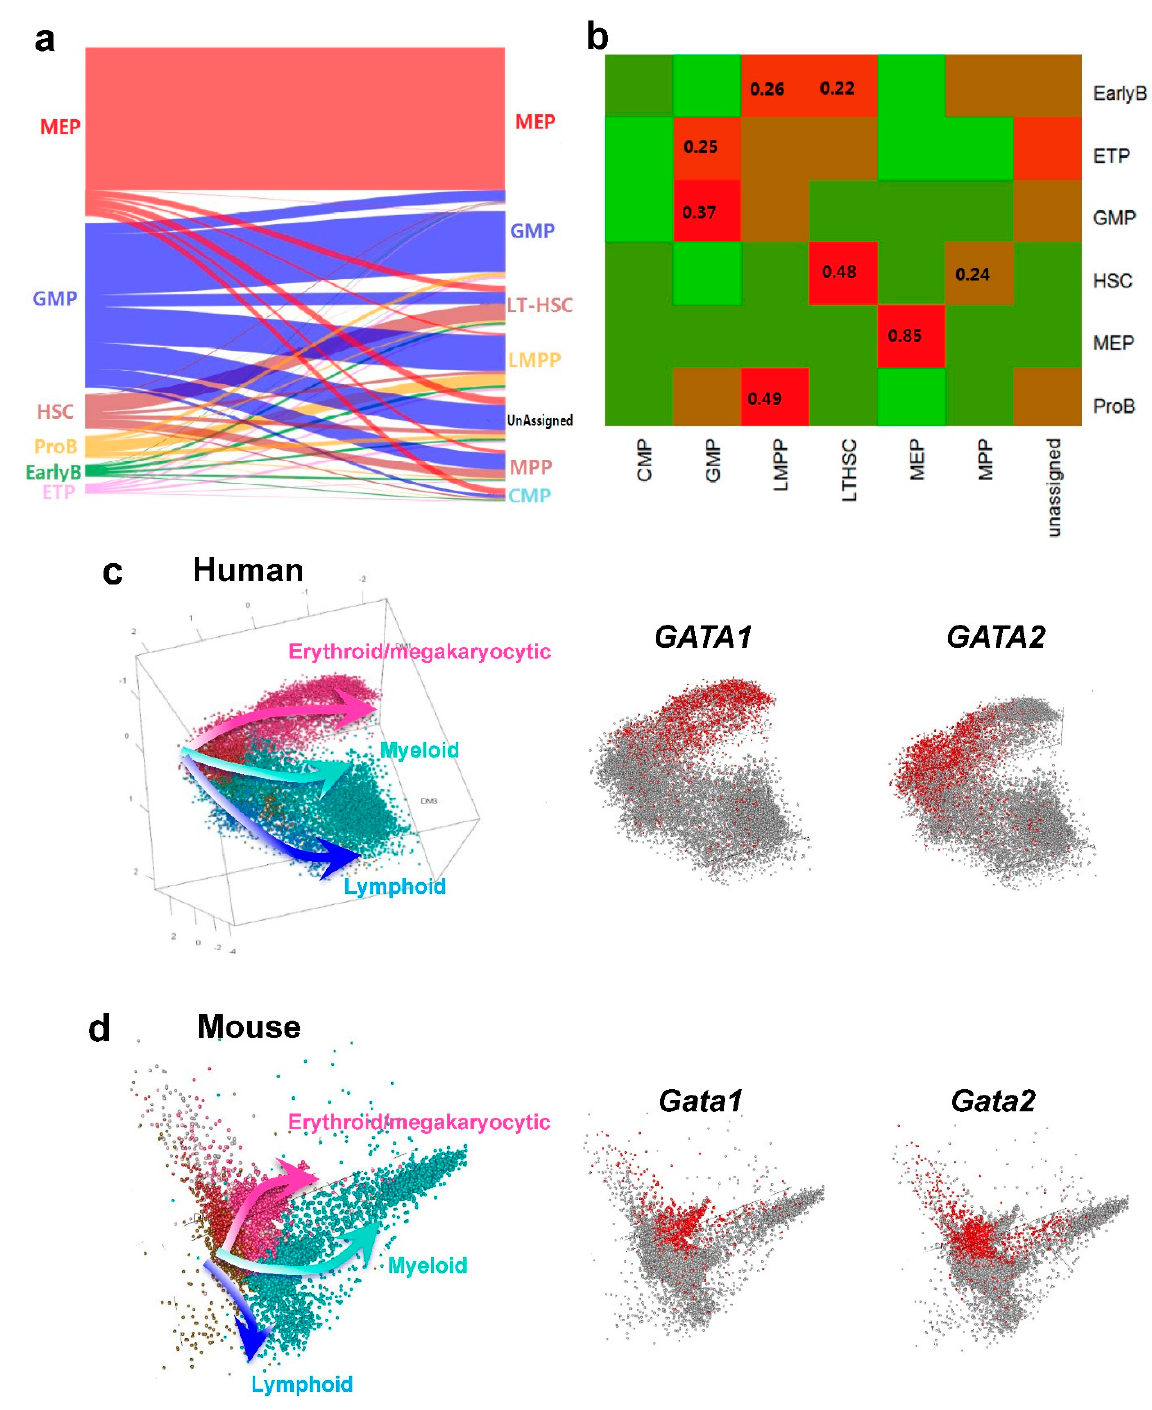
Figure 3. ( a ) Sankey diagrams of scmap-cluster projection of human dataset to mouse dataset. Each row is a cell of human, colored with cell types. ( b ) Fractions of human cell populations projected to mouse cell types. Cells tended to be projected to the corresponding cell population defined in mouse; for example, 85% of MEP mouse cells were mapped to human MEP cell types. ( c , d ) Monocle revealed linage differentiation trajectories of human ( c ) and mouse ( d ) HSPCs. Cells (balls, colored based on predicted cell type) are arranged in a 2D space calculated with Independent Component Analysis. The results obtained with Monocle 2 are shown in Figure S3, showing the same themes. Expression of GATA1 and GATA2 for lineages are highlighted in a differentiation tree, showing a clear GATA2 and GATA1 switch during